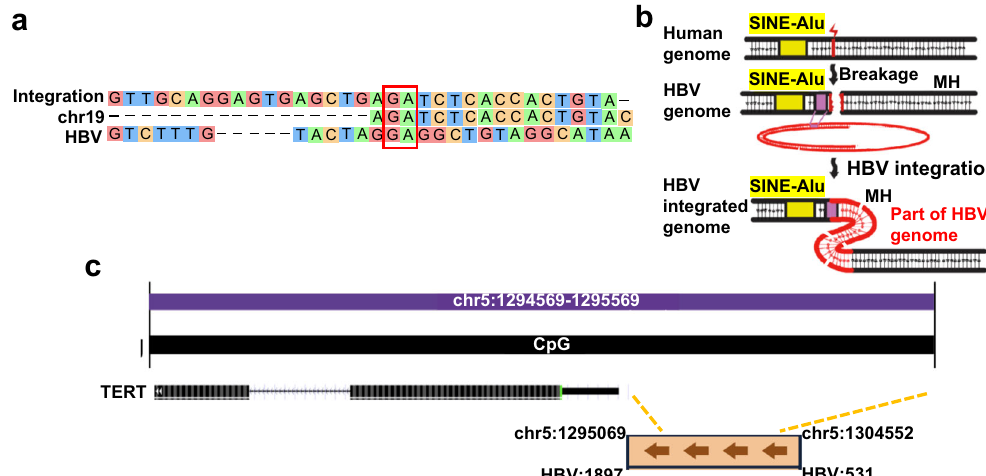
Fig. 4 HBV integration mechanisms in HBV: 2373, chr19: 29838018, and HBV: 1900, chr5: 1295069. a Alignment of the sequence around the integration site between the human genome and the HBV genome. Different colors represent different nucleotide types. The red box represents the aligned nucleotides in the MH of the two reference sequences in the HBV integration site. b Schematic of a mechanism connecting breakage of the human genome around SINE-Alu motifs with the integration of the HBV genome. Yellow, SINE-Alu; purple, MH; red, HBV sequence. c HBV integration pattern in chr5. Yellow dotted line indicates Human chr5 breaks at nt 1295069 and nt 1304553 for HBV nt 1897 and nt 531 integration. the position of HBV integration breakpoints, which are near exon 1 of TERT and located in the CpG